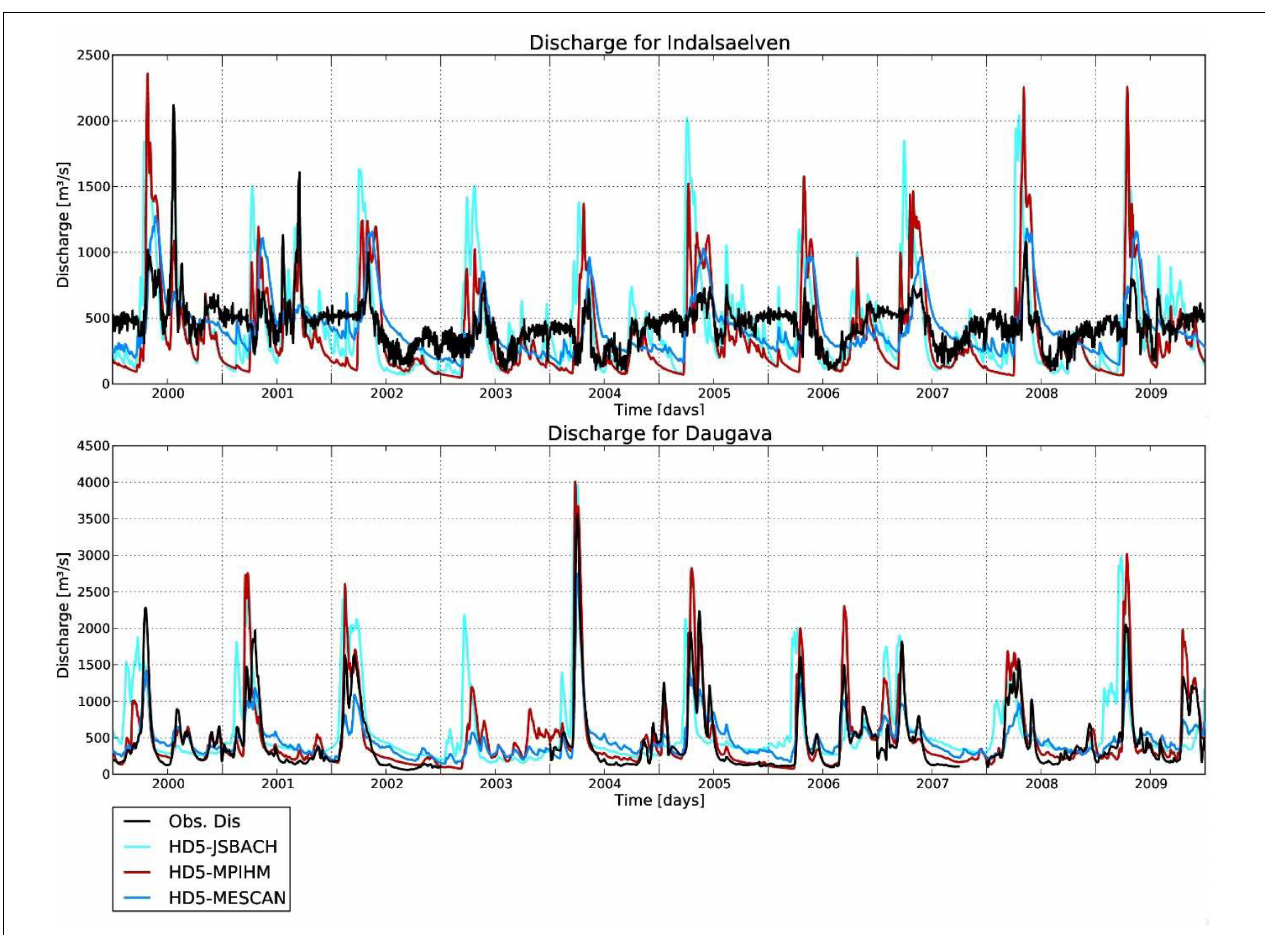
FIGURE 11 | Simulated and observed discharges from 2000–2009 for Indalsälven (25761 km 2 ), and Daugava (64500 km 2 ).